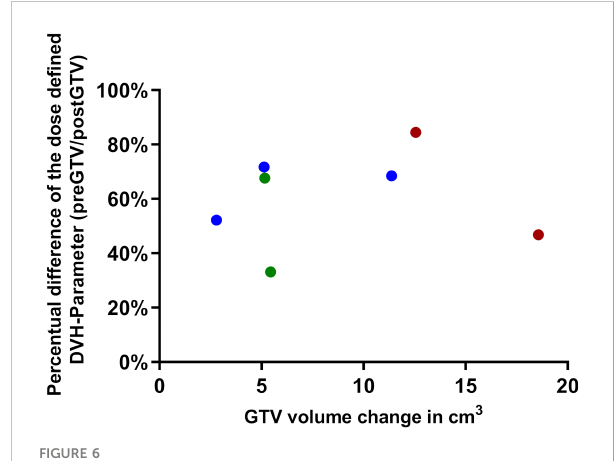
FIGURE 6 Graphical representation for the seven simulated plannings, visualizing the dose-de fi ned dose-volume histogram (DVH) parameter ratio between simulated NaSRS and postoperative original irradiation (pre/post) against the absolute difference in GTV volume. Fractionations are color coded: Single fraction in green, 3- fractions in blue, and 5-fractions in red. GTV, gross tumor volume.